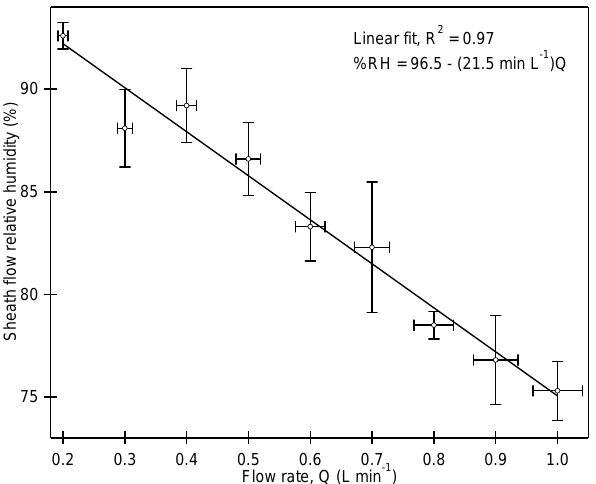
Fig. 4. OPC calibration with glass and silica microspheres (left axis) and the dimensionless scattered intensity from Mie theory for water droplets and size standards (right axis). The observed droplet size values reflect the mean and standard deviation of a Gaussian fit to the OPC distribution. The right axis limits were visually aligned to fall on the one-to-one